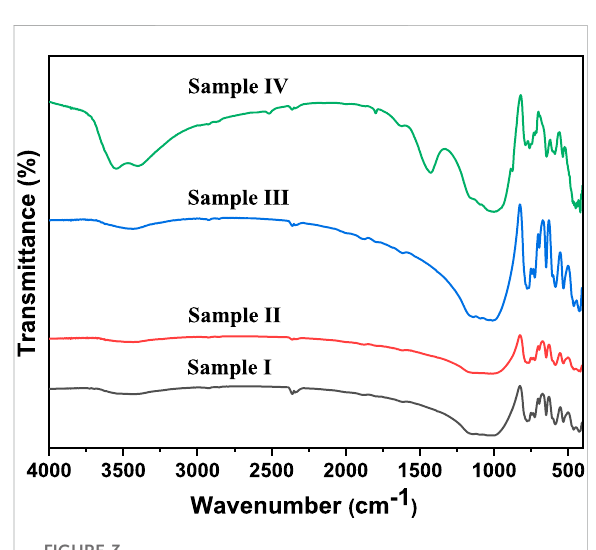
FIGURE 3 FTIR spectra of the rock samples analyzed in this